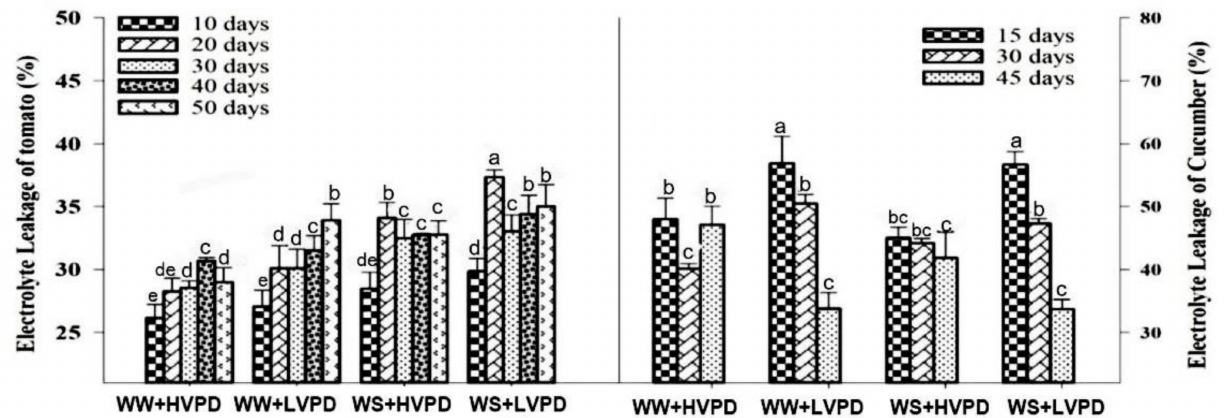
Figure 3. Effects of VPD and soil moisture on the EC of tomato and cucumber plants. Data are presented as means ± standard error ( n = 10). Letters represent significant differences between treat- ments. Different letters indicate significant difference ( p < 0.05). WW (well-watered, 100%FC) + HVPD (high vapor pressure deficit); WW (well-watered, 100%FC) + LVPD (low vapor pressure deficit); WS (water stress, 60%FC) + HVPD (high vapor pressure deficit); WS (water stress, 60%FC) + LVPD (low vapor pressure deficit).